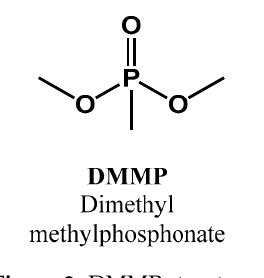
Figure 2. DMMP structure.